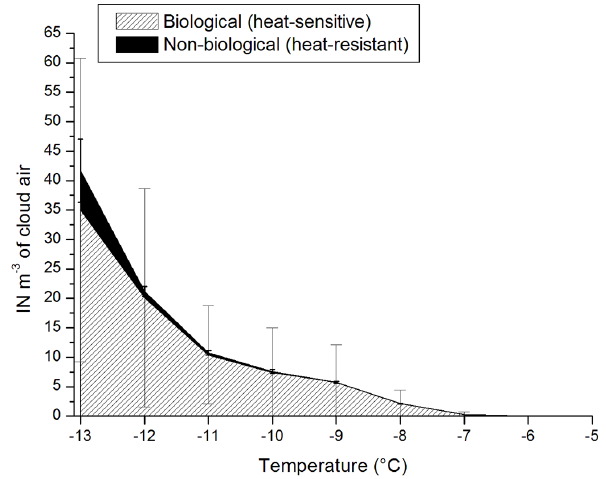
Figure 4. Mean cumulative concentrations of biological (heat- sensitive. shaded area) and non-biological (heat-resistant, black area) IN in clouds ( n = 12) per volume of air. The sum of the two categories corresponds to the mean concentration of total IN. The lower bound was considered for values below the detection